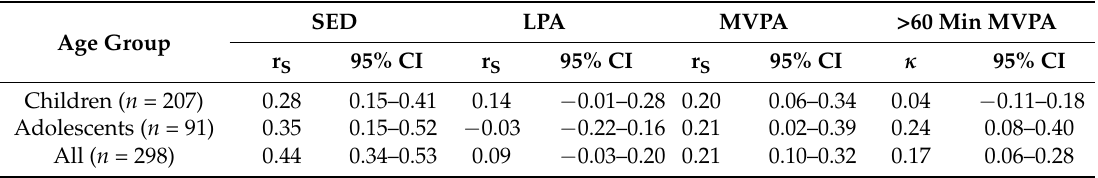
Table 3. Correlation of self-reported and objectively measured PA in children and adolescents ( n =